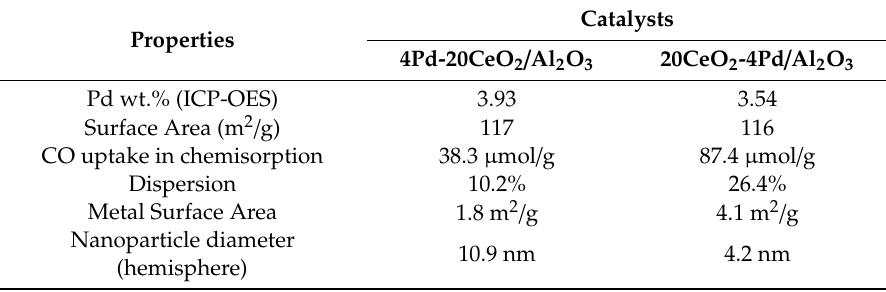
Table 1. Properties of the catalysts.